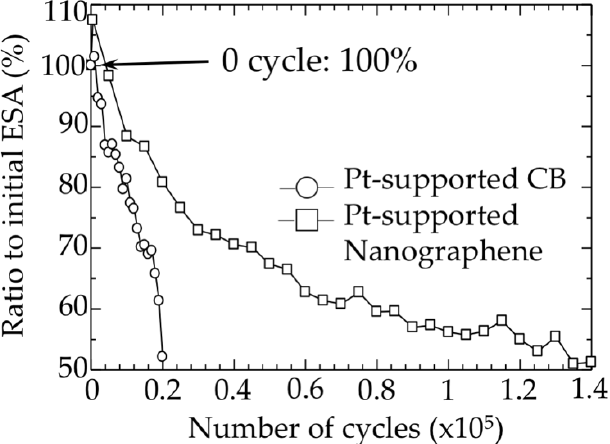
Figure 4. High electric potential durability test result of Pt nanoparticle-supported carbon black and nanographene.